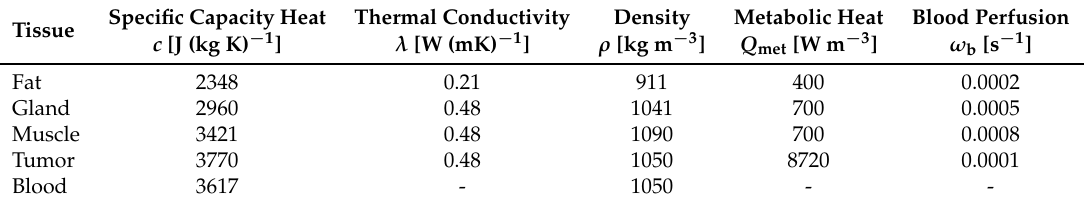
Table 3. Thermo-physical properties of the biological domains that were used in the simulation. The values were obtained from Refs.